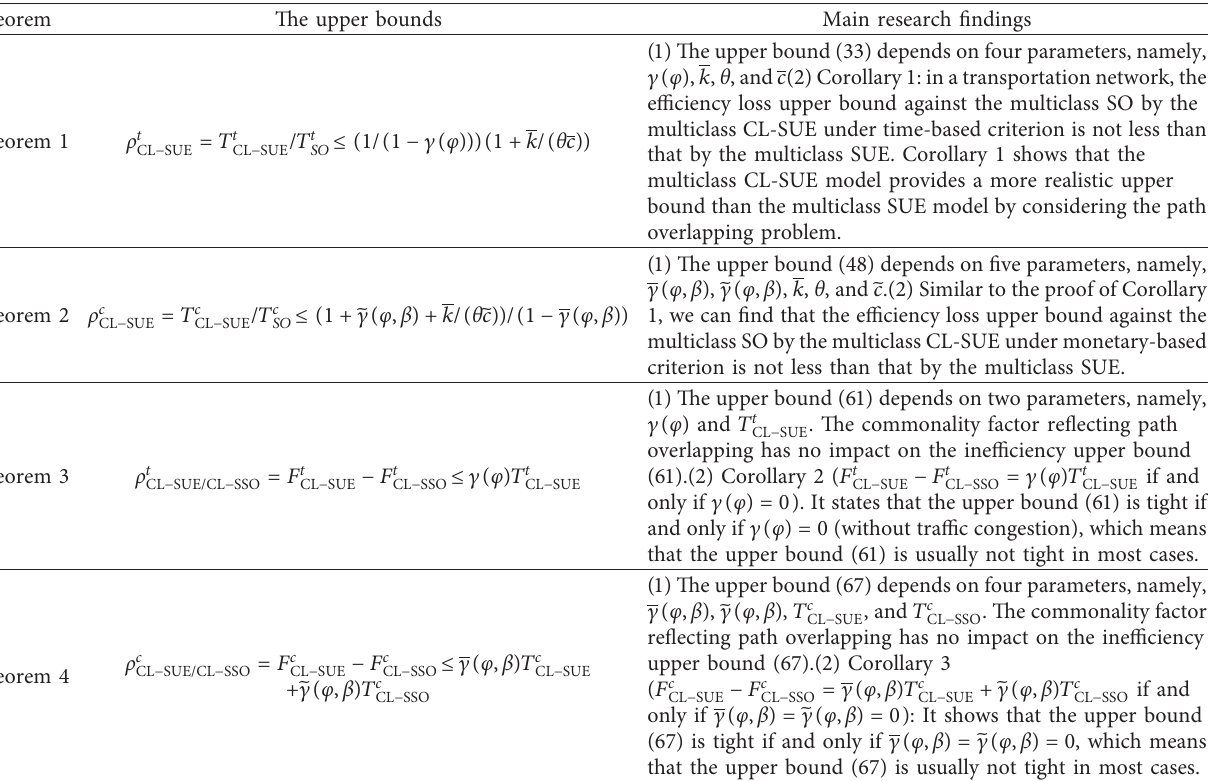
Table 3: The main research findings of four theorems.